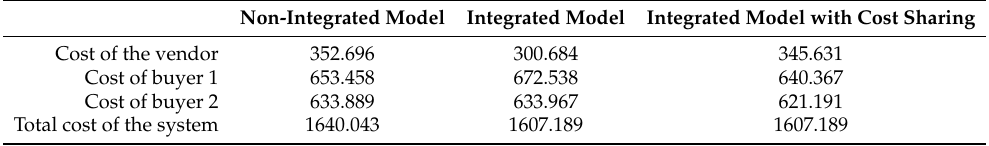
Table 3. Costs for each member of the